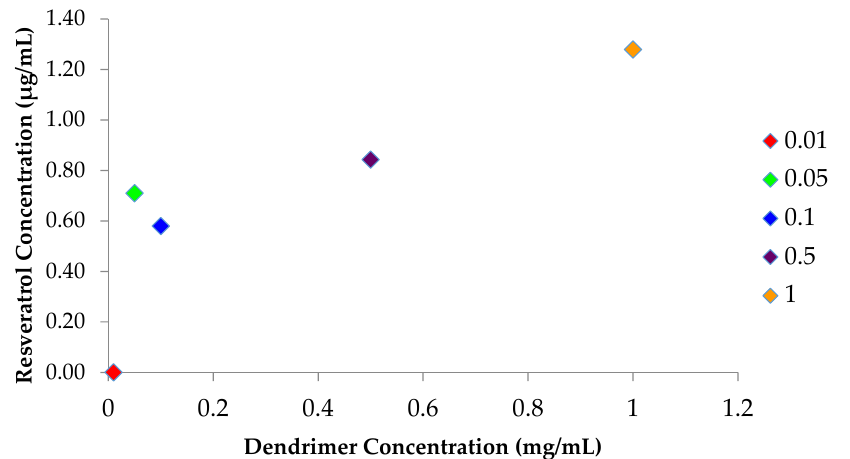
Figure 4. Solubility profile of dendrimer-RSV complex. Mean RSV concentration plotted against dendrimer concentration ( n = 3), p < 0.05.